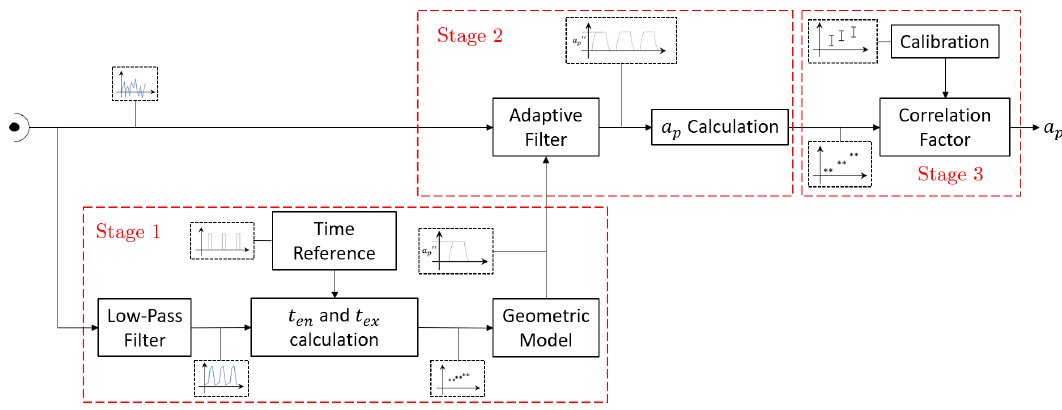
Figure 5. Block diagram of the